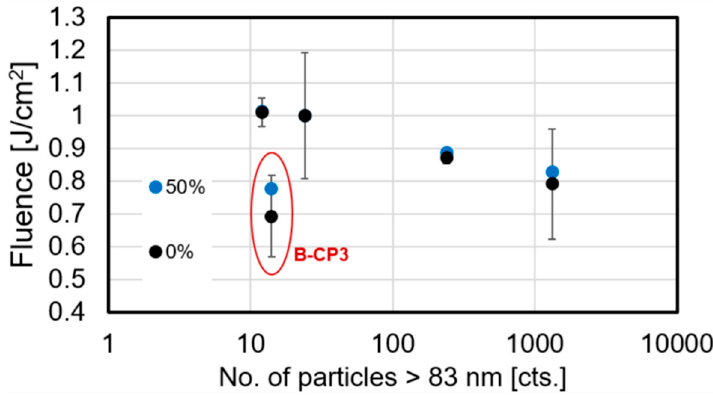
Figure 9. Normalized fluence of the 0% and 50% LIDT from Figure 6b as a function of measured (total) number of particles.